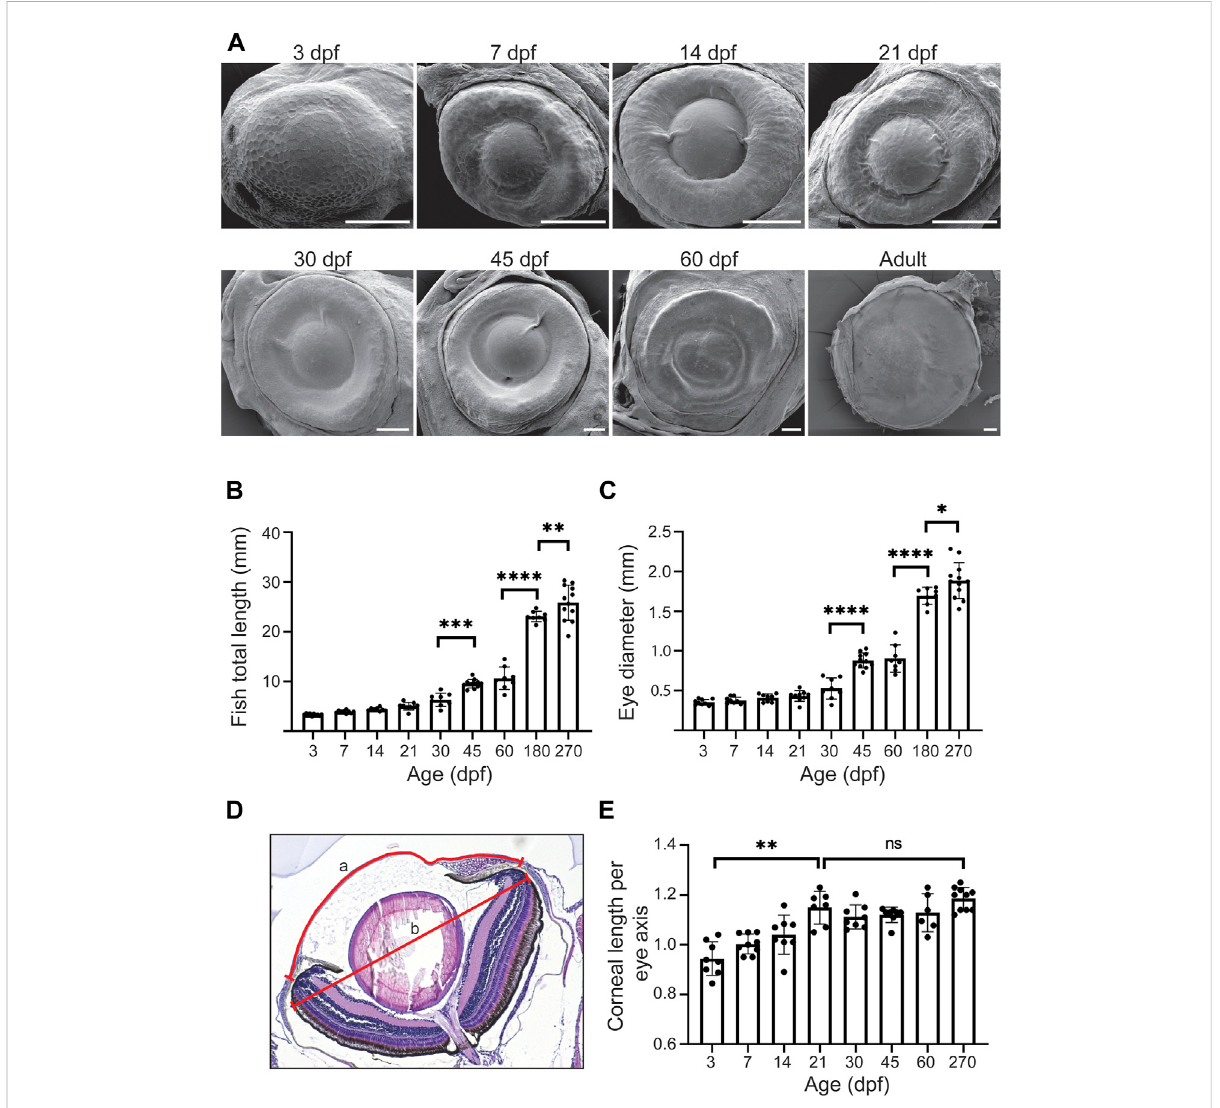
The growth dynamics of the eye and the cornea. (A) Representative SEM images of the eye in fi sh of different age (dpf, days post-fertilization, 3 samples were checked per age group). (B,C) Total length (B) and eye diameter on anterior-posterior axis (C) (n = 8 – 12, one-way ANOVA with Sidak ’ s multiple comparisons test). (D,E) Corneal length on anterior-posterior axis, normalized to the maximum eye diameter, shown in (D) and quanti fi ed in (E) (n = 6 – 10, Kruskal-Wallis test with Dunn ’ s multiple comparisons test). The results represent mean ±